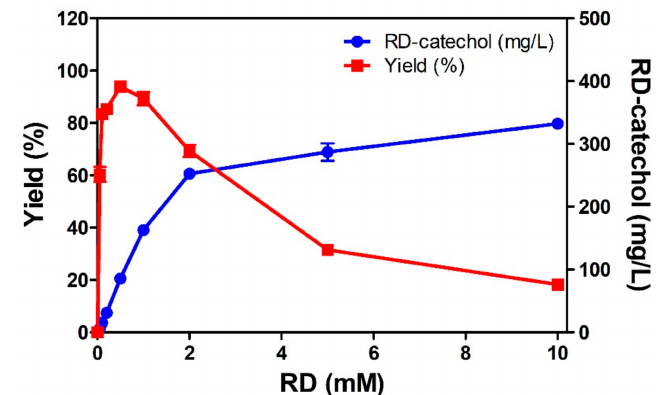
Figure 6. RD-catechol production by Ty with increasing RD concentration. The reaction mixtures contained five units of Ty, indicated concentrations of RD, and 10 mM LAA. RD-catechol produced by Ty was analyzed using HPLC.